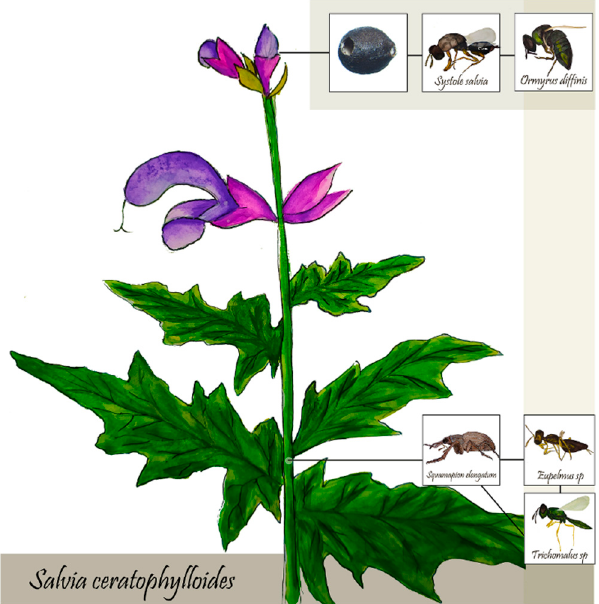
Figure 4. Complex of herbivores and their parasitoids present on S. ceratophylloides . Plants attacked by S. elongatum do not produce inflorescences and become visibly chlorotic. Top: Seed with hole and seed feeder species Systole salviae and its parasitoid Ormyrus diffinis . Bottom: S. elongatum and